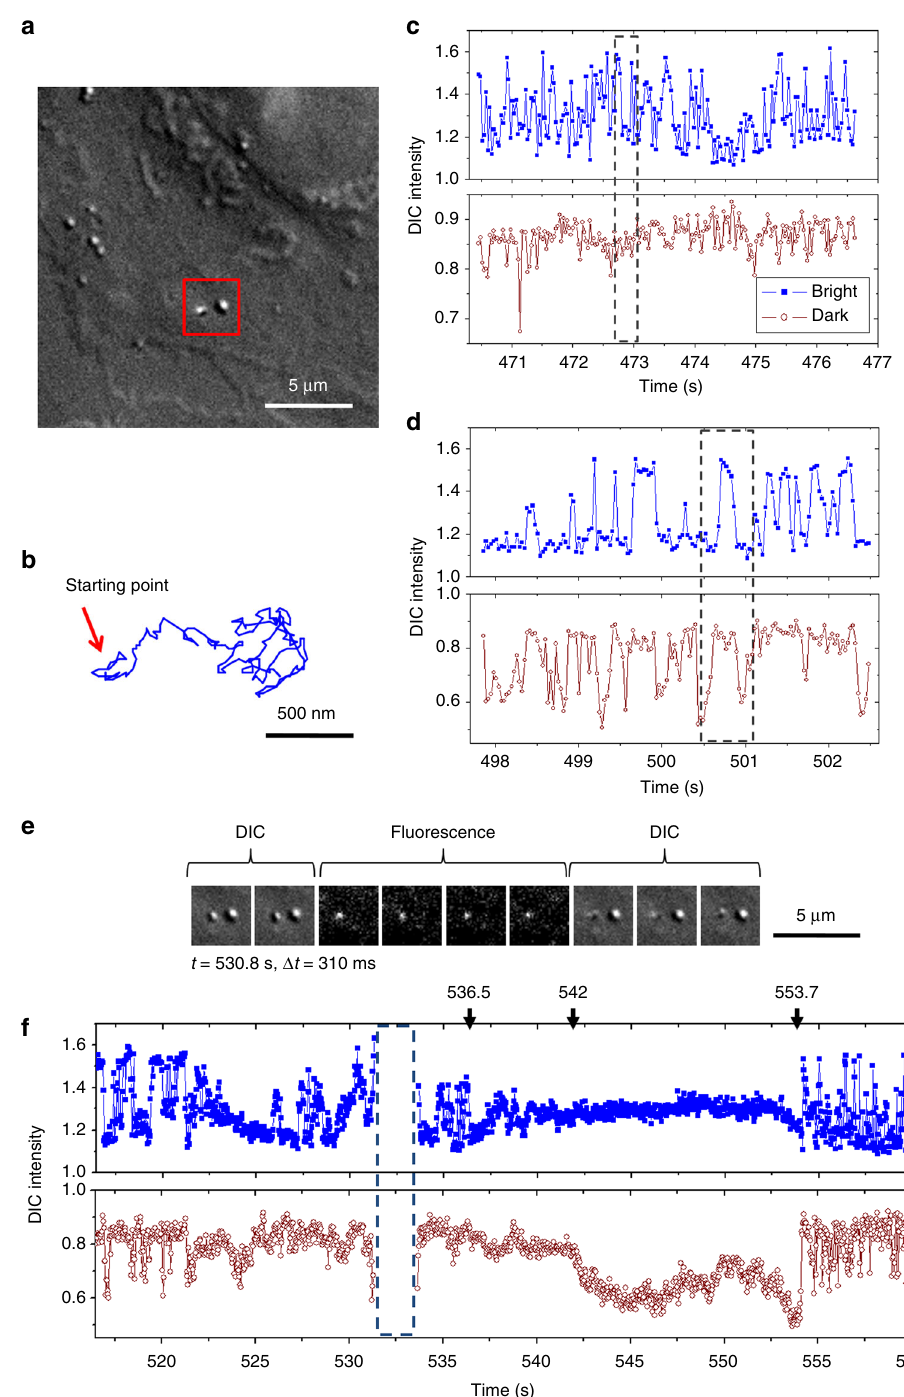
Fig. 3 A complete CME event of a gold nanorod by an A549 cell. Corresponding video are presented in Supplementary Movies 1 – 6. Time 0 is set to the moment when the nanorod fi rst appeared on the membrane. a The cell and the location of the gold nanorod probe on the cell membrane. The nanorod (on the left in the red box) was beside a cell feature (on the right in the red box) that showed a constant contrast throughout the recording. b The trace of the nanorod ’ s active translational movement at an early binding stage (Supplementary Movie 2). c DIC intensities of the nanorod in the same period as b . The framed period shows typical out-of-plane rotations. d DIC intensities of the nanorod at a late stage (Supplementary Movie 3). The framed period shows typical in-plane rotations. e Sequential DIC and fl uorescence images captured in tandem showing that the gold nanorod co-localized with a CCP (Supplementary Movie 4). The movie was acquired at 32 frames per second continuously and the displayed fl uorescence images were the average of 10 consecutive images from the movie. f DIC intensities of the nanorod before and after scission of the nanorod-containing vesicle (Supplementary Movie 5). The blank period from 531.5 to 532.8 s was toggled to fl uorescence mode in checking clathrin fl uorescence. The nanorod lost active rotation at 536.5 s and regained rotational and translational freedoms at 553.7 s. The same particle was observed to lose co-localization of fl uorescence from EYFP-clathrin, indicating the clathrin disassembly (Supplementary Movie 6). Supplementary Movie 7 shows that the particle was actively transported at 45.7 s after scission in DIC